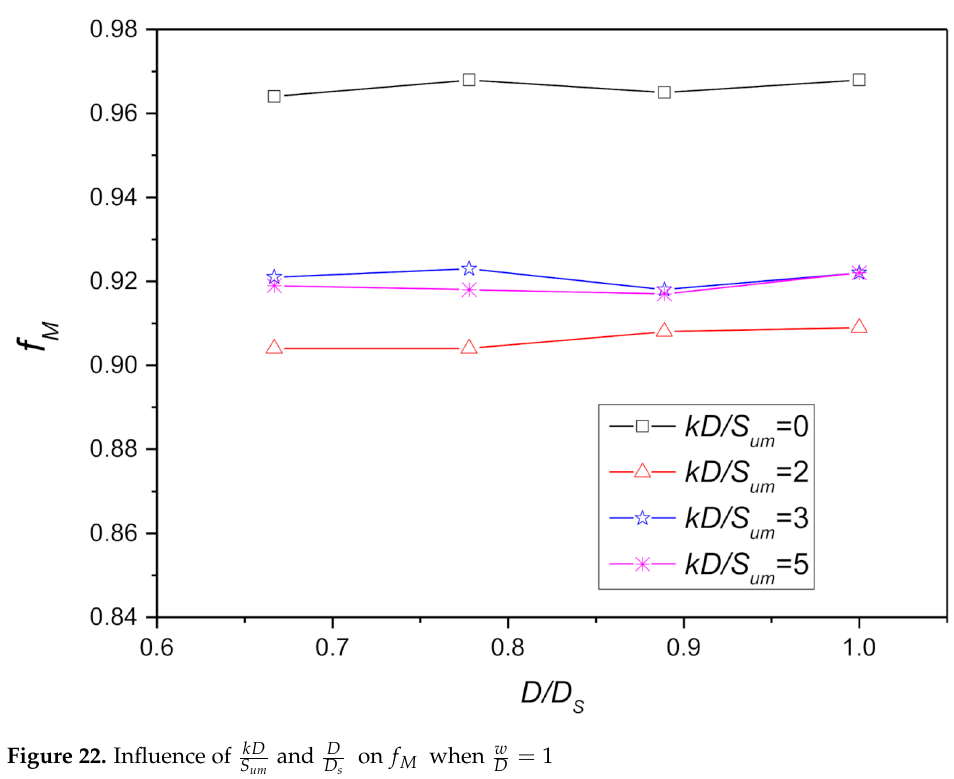
Figure 22. Influence of kD